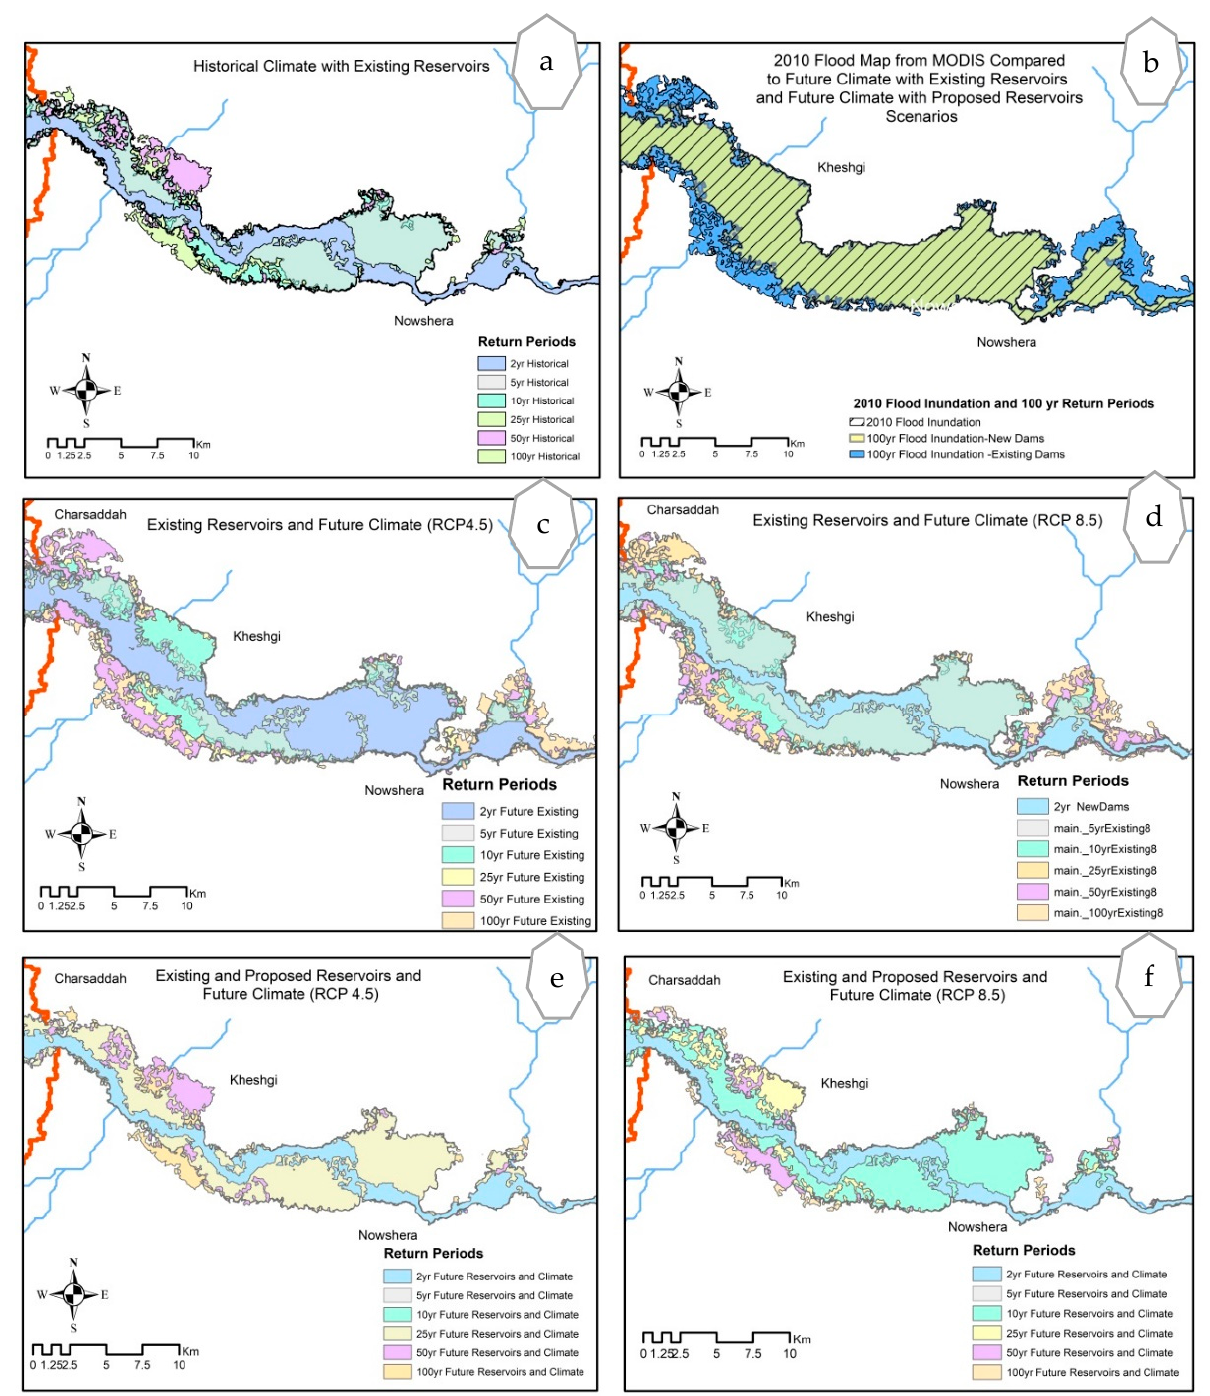
Figure 4. Flood inundation map for the Kabul River at Nowshera for various climate and dam scenarios for various return periods; ( a ) Flood inundation map under current climate and existing dams for various return periods, ( b ) 2010 MODIS flood inundation imagery compared to the simulated 100 year flood inundation map for the existing and proposed dams, ( c ) flood inundation under existing dams and future climate RCP 4.5 scenario, ( d ) existing dams and future climate under RCP 8.5 scenario, ( e ) flood inundation under existing dams and future climate under RCP 4.5 scenario, and ( f ) flood inundation under proposed dams and future climate conditions RCP 8.5 scenario.